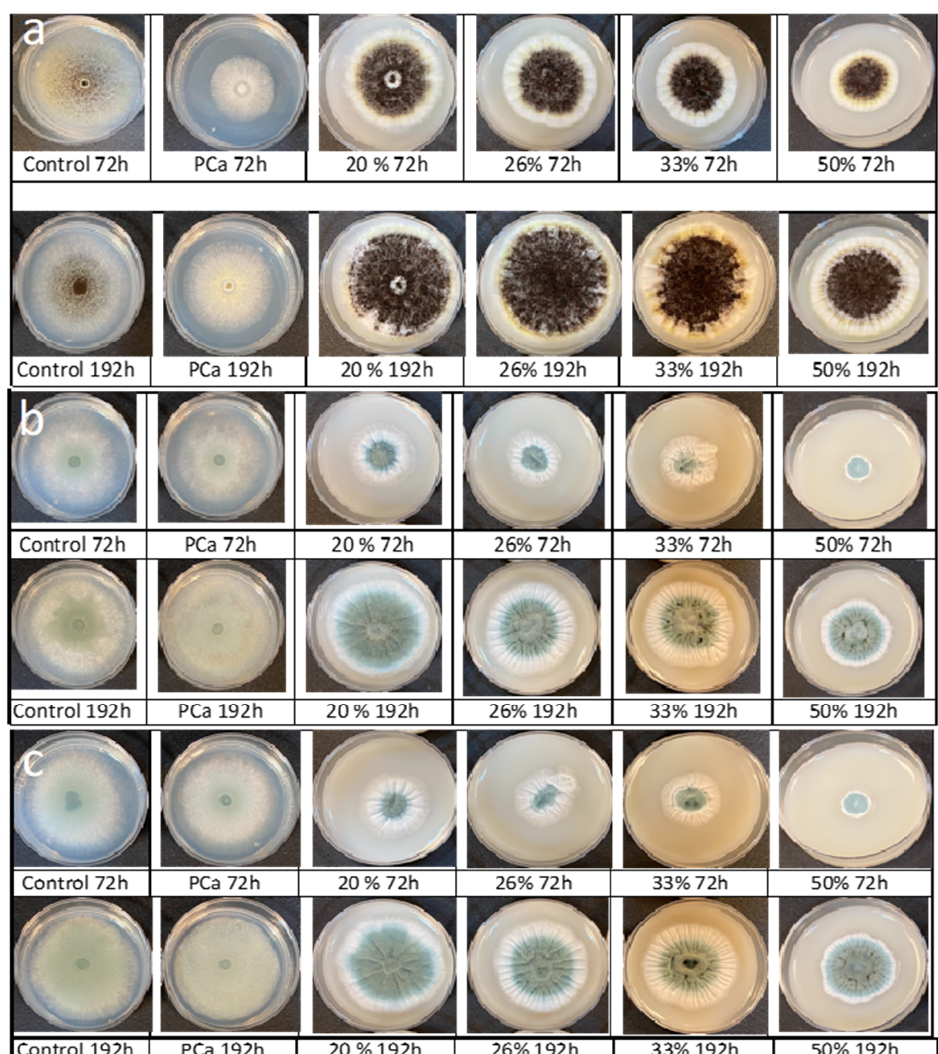
Figure 5. Radial growth of molds treated with different levels of pasteurized aqueous extracts from poolish-type sourdough fermented (48 h) with Lactiplantibacillus plantarum NRRL B-4496 (20, 26, 33, or 50%) or 0.3% calcium propionate (PCa) after 72 and 192 h of incubation at 25 °C. ( a ) Aspergillus niger , ( b ) Penicillium chrysogenum , and ( c ) Penicillium corylophilum .